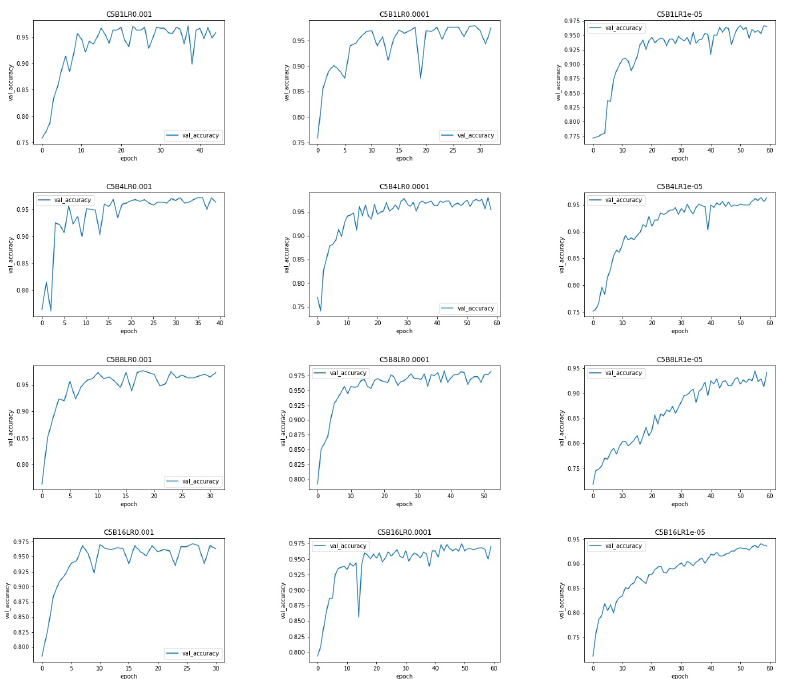
Figure 7. Five convolution block with different batch number and learning rate.